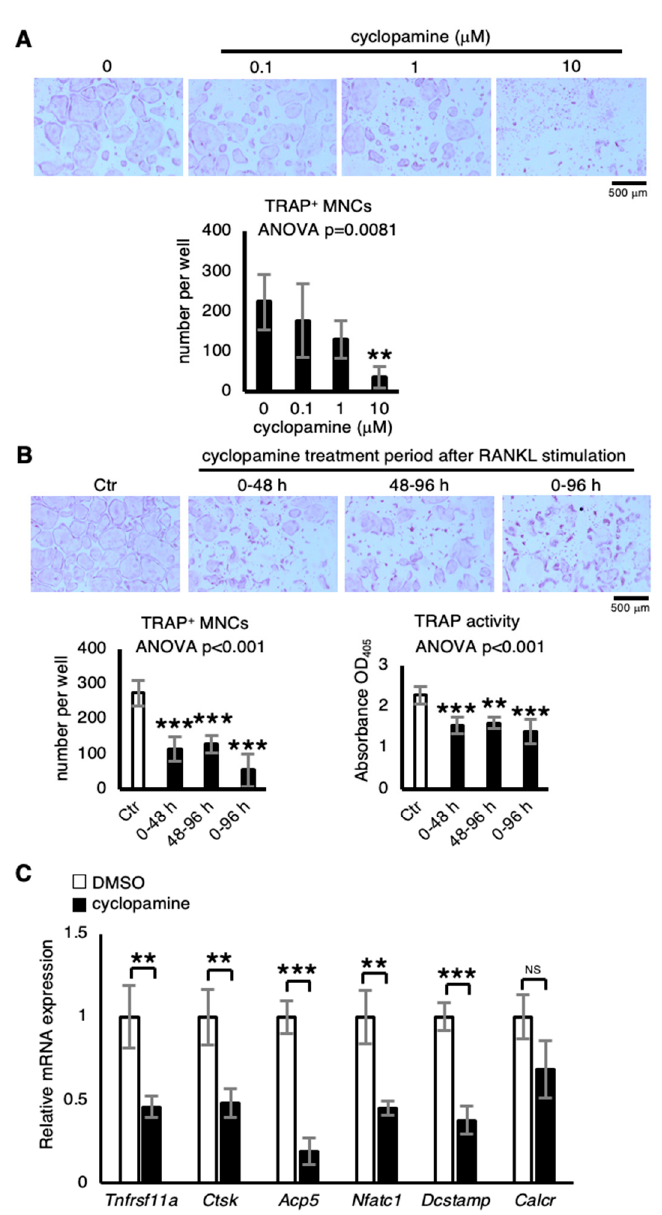
Figure 2. Cyclopamine suppresses osteoclastogenesis. ( A ) The effect of cyclopamine on osteoclast formation. The number of TRAP + multinuclear cells (MNCs) were counted ( n = 4). ( B ) Osteoclastogenic cultures treated with 10- µ M cyclopamine throughout the 96 h period (0–96 h) or only during the first (0–48 h) or second period (48–96 h); the number of TRAP + multinuclear cells (MNCs) and TRAP activity determined 96 h after RANKL stimulation ( n = 4). ( C ) E ff ect of cyclopamine treatment on osteoclastic gene expression in osteoclastic cultures ( n = 3). Abundance of target mRNA normalized by that of Actb mRNA. Data are represented as means ± s.d. One-way ANOVA, followed by Dunnett’s test ( A , B ) or unpaired two-sided Student’s t -test ( C ); NS, not significant; ** p < 0.01 and *** p <